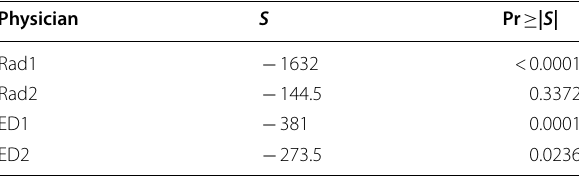
Table 1 Wilcoxon signed-rank test: pre-post rating